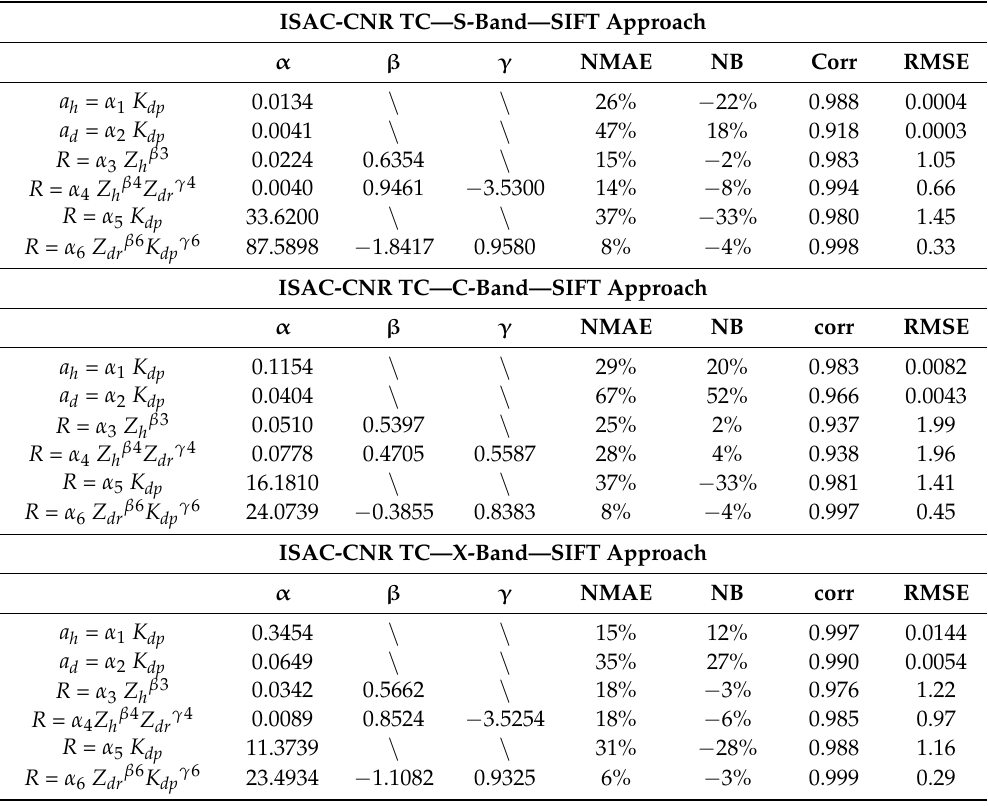
Table 5. Coefficients of the estimators (9)–(14) obtained from ISAC-CNR TC dataset for S-, C- and X-bands along with the values of the NMAE (in %), NB (in %), corr and RMSE (in dB km − 1 or mm h − 1 ). ISAC-CNR TC—S-Band—SIFT